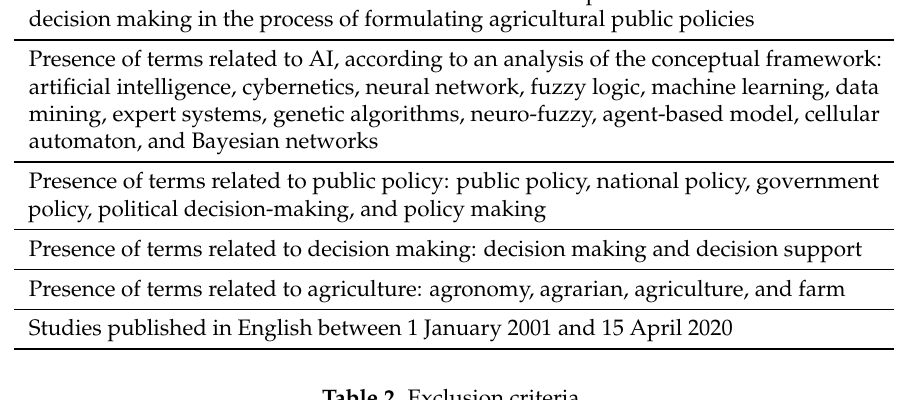
Table 2. Exclusion criteria.